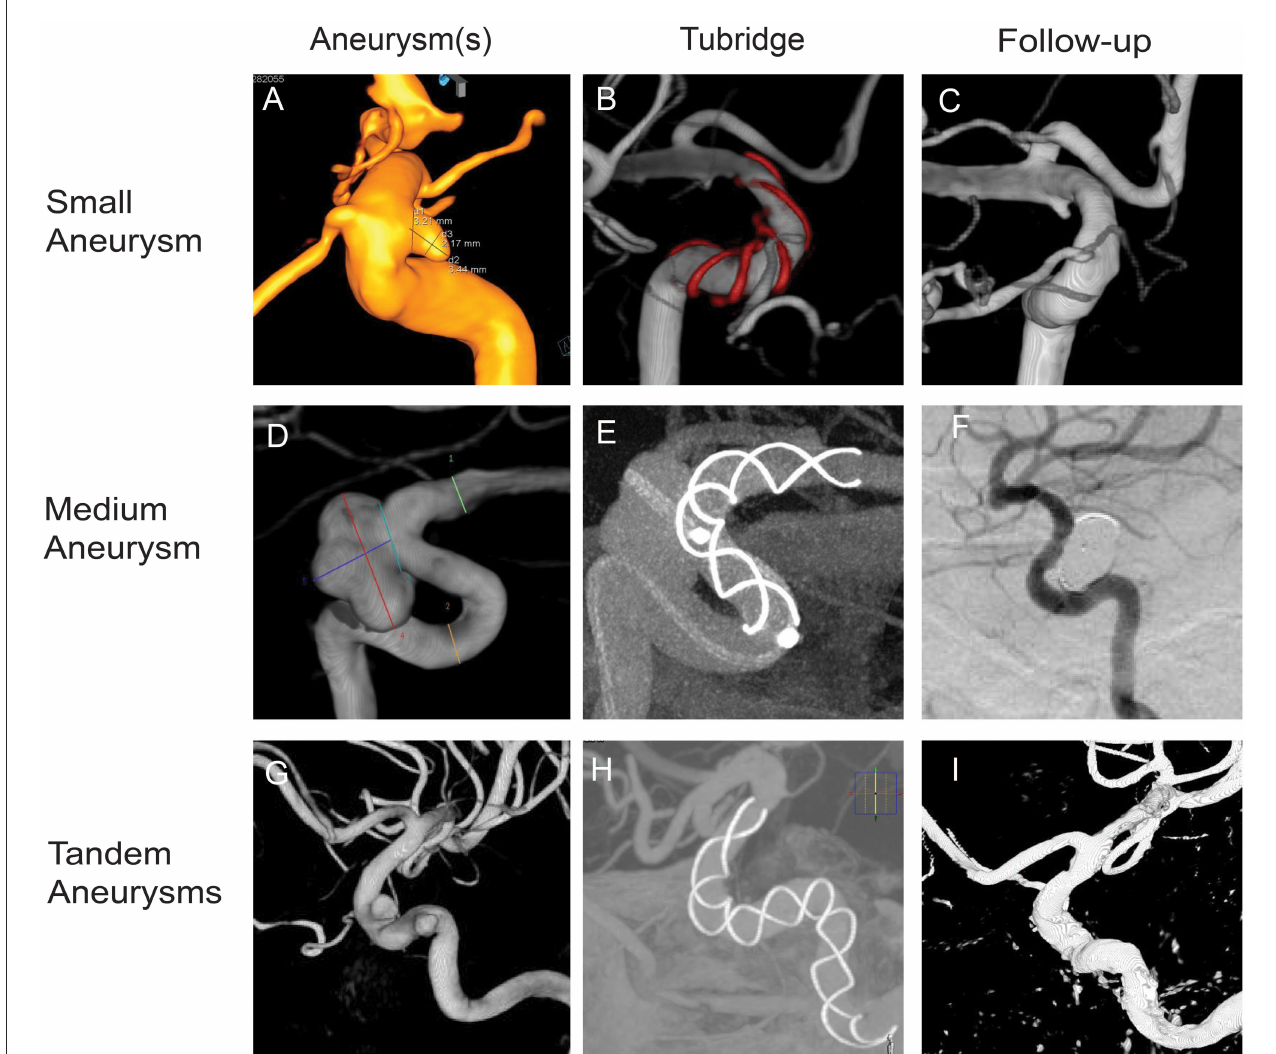
FIGURE1 Tubridge flow diverter deployment of small, medium, and tandem aneurysms. (A) Small aneurysm, 3.44mm × 2.17mm, neck 3.21mm; parent artery diameter, 4.5–3.3mm. (B) Stent size 4.0–25. (D) Medium aneurysm, 10.00mm × 7.44mm, neck 5.99mm; parent artery diameter, 4.2–3.0. (E) Stent size, 3.5–25. (G) Tandem aneurysms, 4.81mm × 3.77mm, neck 4.17mm. 4.36mm × 3.09mm, neck 4.48mm; parent artery diameter, 5.2–4.5. (H) stent size, 5.0–45. (B, E, H) Show the opening of the Tubridge flow diverters. (C, F, I) Show complete occlusion with the Tubridge flow diverters and